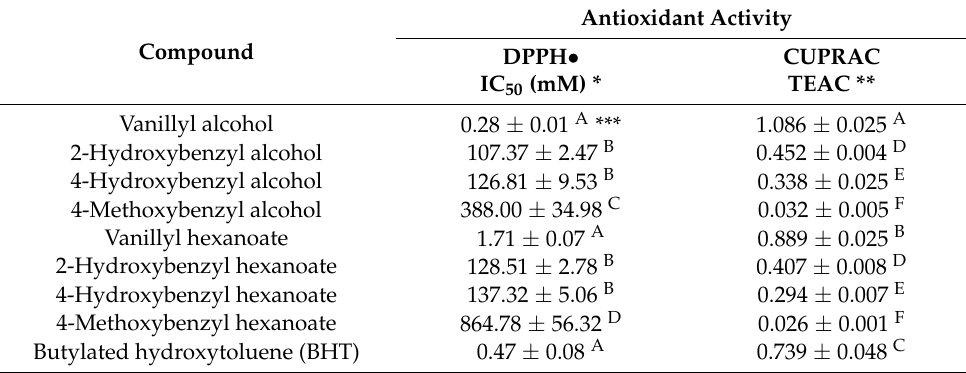
Table 1. Comparison of antioxidant activity of tested compounds by means of methods with DPPH • radical and